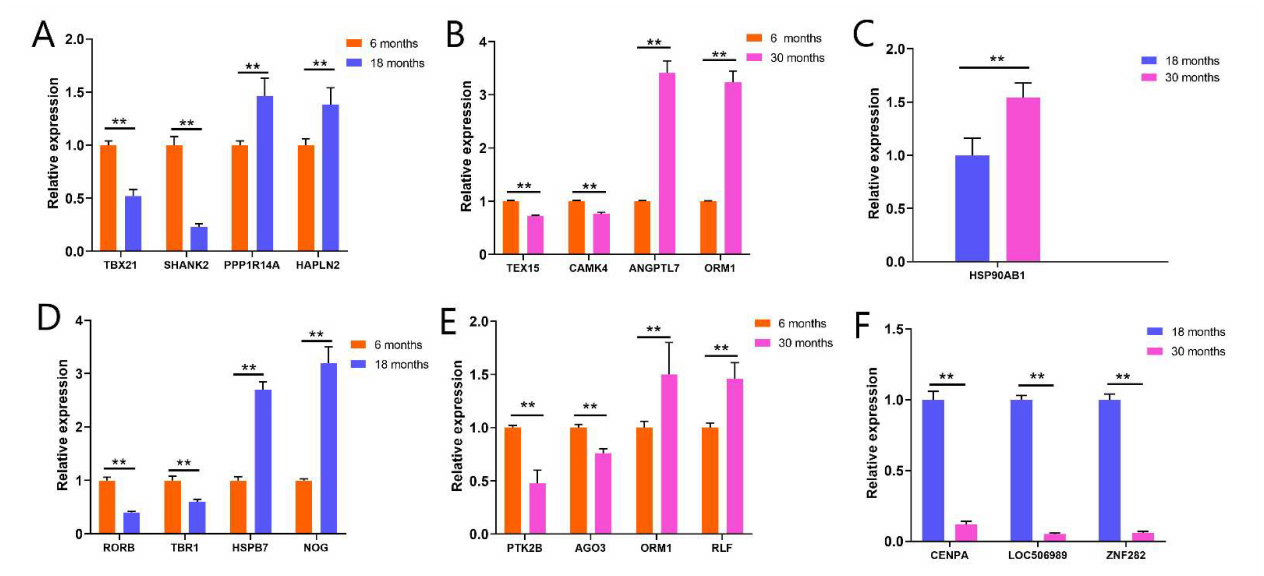
Figure 5. Differential gene expression levels in the pituitary and hypothalamus: ( A ) The results of G3 vs. G1; ( B ) the results of G5 vs. G1; ( C ) the result of G5 vs. G3; ( D ) the results of G4 vs. G2; ( E ) the results of G6 vs. G4; ( F ) the results of G6 vs. G4. (G1, G3, and G5 = 6-month-old, 18-month-old, and 30-month-old Angus cattle pituitary, respectively; G2, G4, and G6 = 6-month-old, 18-month-old, and 30-month-old Angus cattle hypothalamus, respectively). ** p <